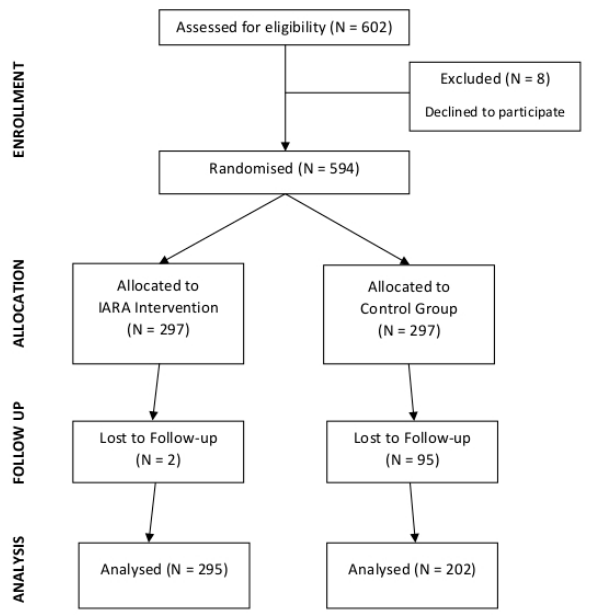
Figure 1. Flow diagram of the progress through the phases of a two ‐ group parallel randomized trial.